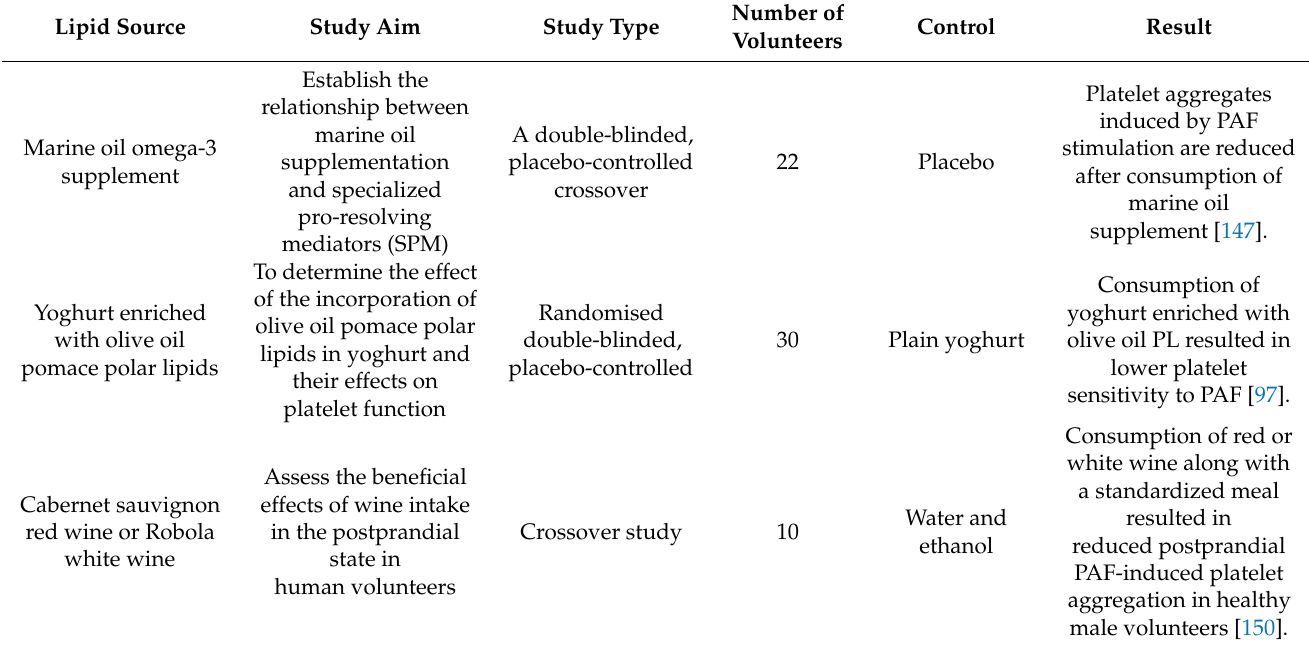
Table 3. Studies investigating the ex vivo antiplatelet properties of animal lipids and alcoholic